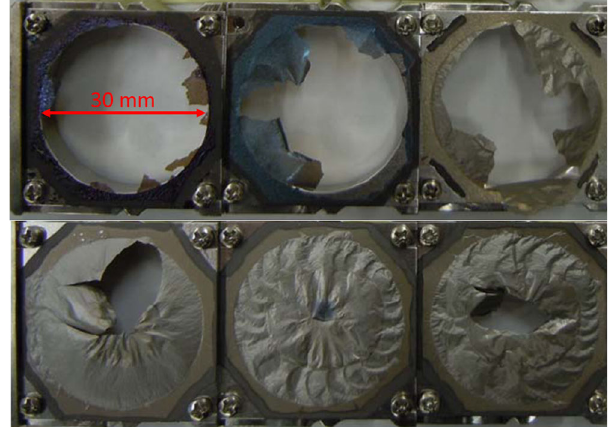
FIG. 2. Damage shown to solid carbon stripper foils irradiated by 5 – 6 emA of U 4 þ with a rms focal spot radius ≈ 5 mm, the foils were made mainly at the GSI target